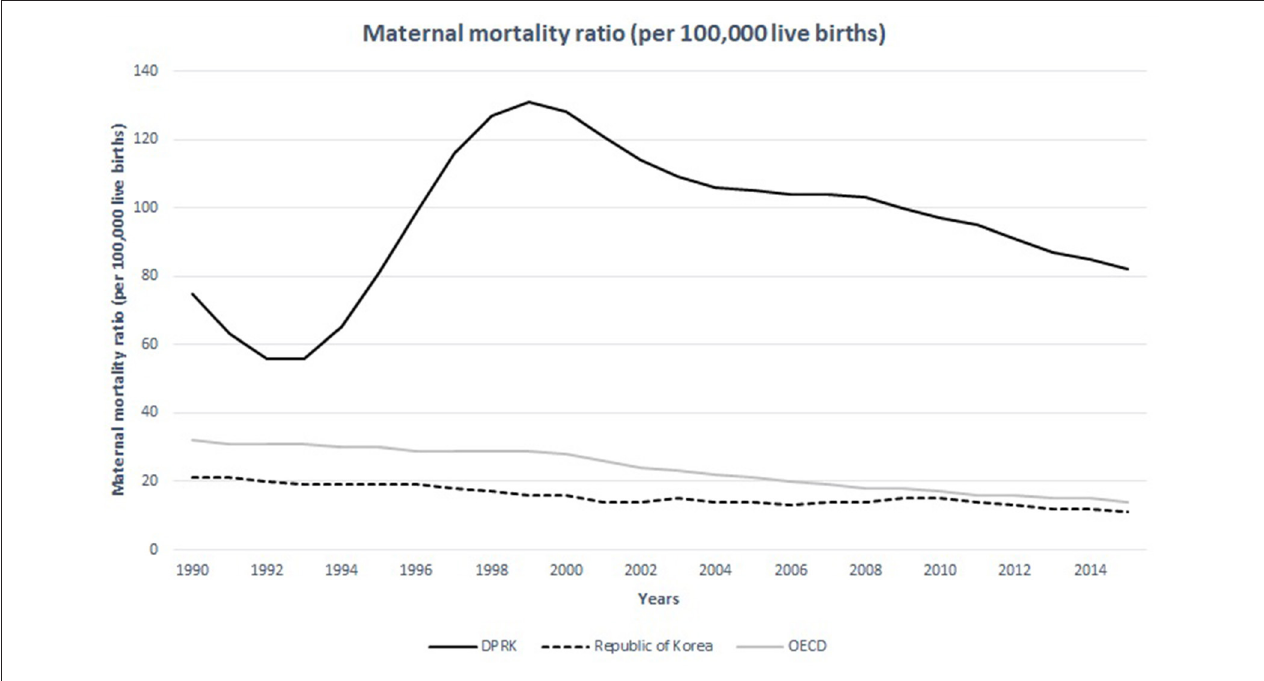
FIGURE 3 | The hierarchical healthcare system of North